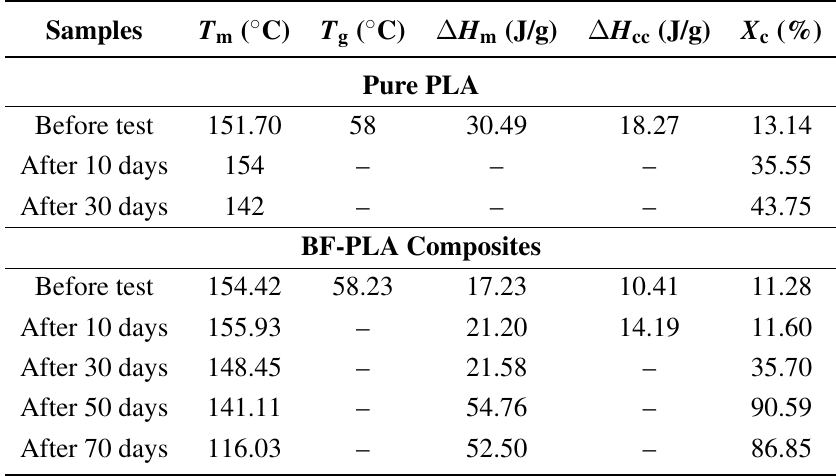
Figure 6. DSC thermograms of virgin PLA ( a ) and BF-PLA ( b ) composites in controlled composting condition. Table 3. DSC numerical data of BF-PLA composites after biodegradation in controlled composting conditions.